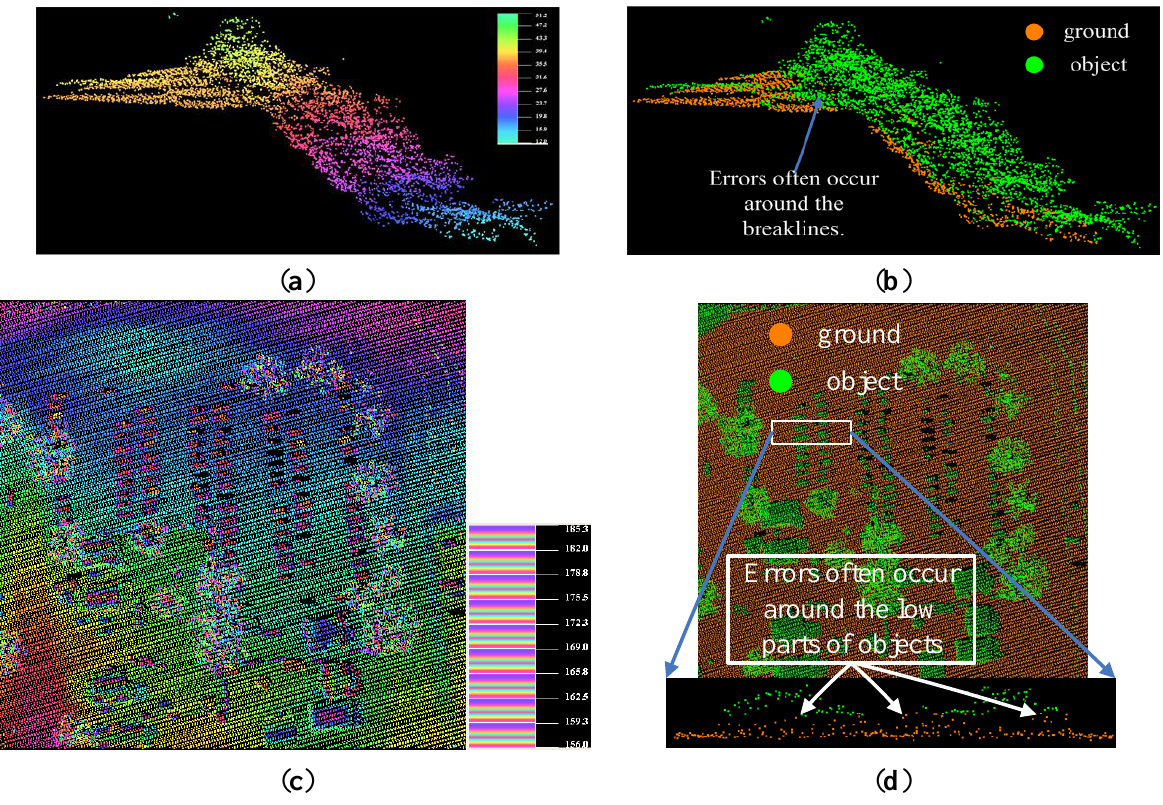
Figure 1. Typical errors of Axelsson’s progressive TIN (triangular irregular network) densification (PTD) filter. ( a ) A point cloud around a step edge; ( b ) Filtering result of the point cloud in (a); ( c ) A point cloud in urban area with dense vehicles; ( d ) Filtering result of the point cloud in